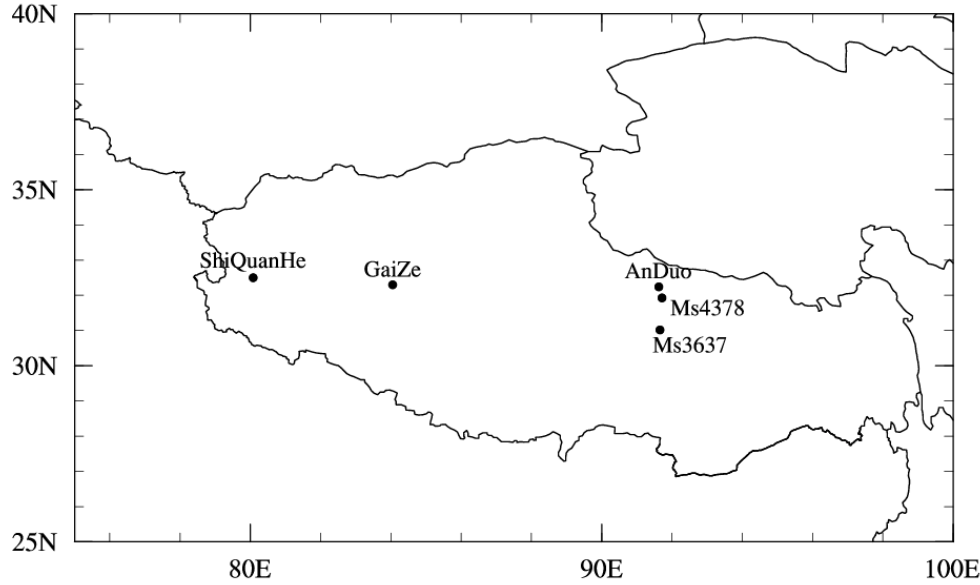
Figure 1. Map of the five observational sites within the TP (i.e., AnDuo, Ms3478, Ms3637, GaiZe and ShiQuanHe). Table 1. Descriptions of the selected observational sites.